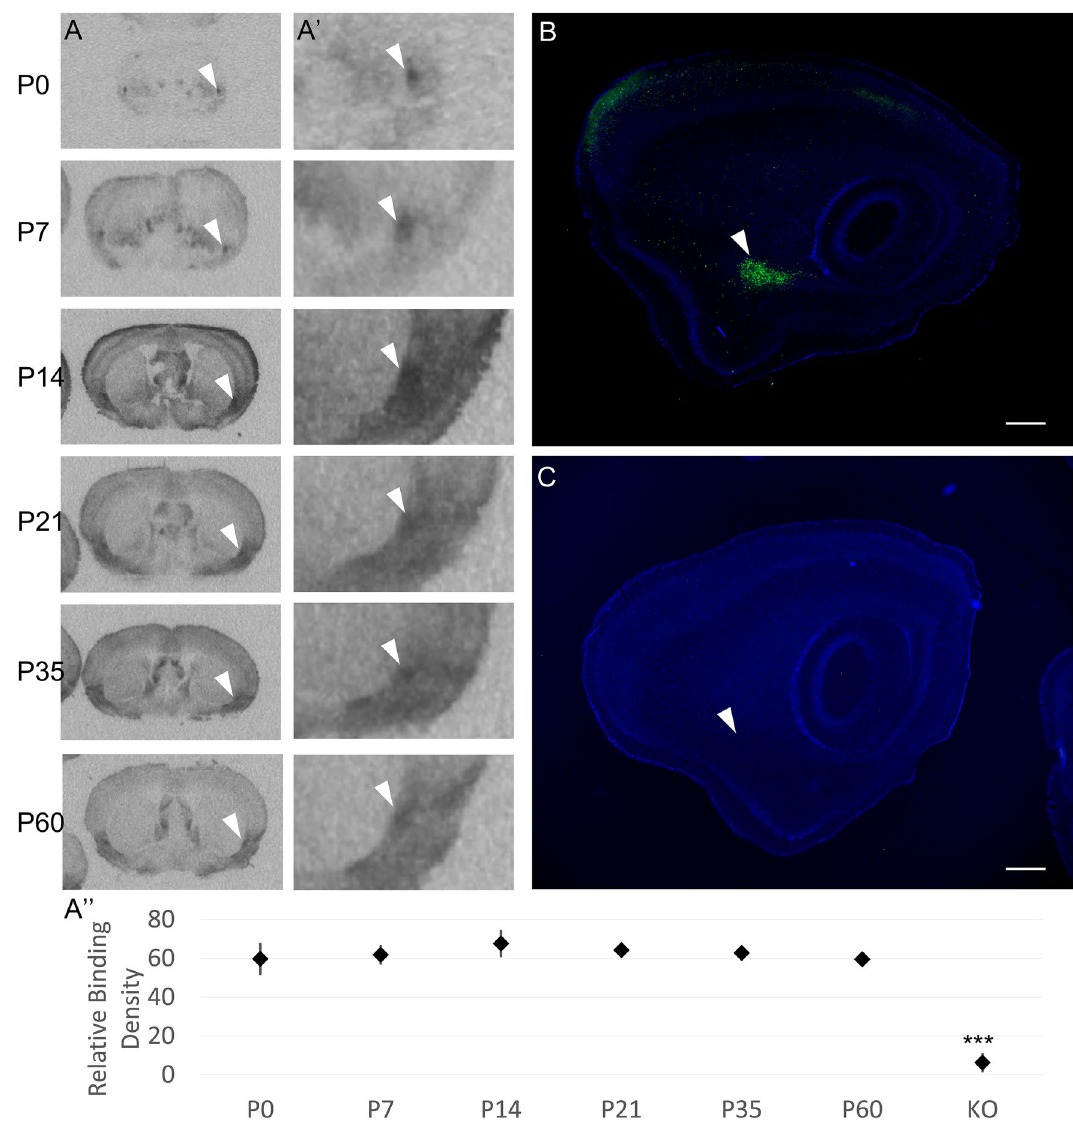
Figure 1. OXTR is produced by and present in the endopiriform nucleus (EPN) across development in mice. ( A ) Previously unpublished autoradiographic images selected from prior work by Hammock and Levitt (2013) demonstrate OXTR ligand binding in the EPN from birth in C57BL/6J mice. White arrowheads in A and A ′ (4 × zoom) point to the dorsal EPN in the coronal plane at post-natal day 0 (P0), P7, P14, P21, P35, and P60. OXTR ligand binding was present in both males and females at all ages examined. ( A ″ ) There were no significant differences across age or sex. All ages were significantly different from adult OXTR knock-out (n = 3 per age/sex, relative binding mean ± S.E.M., ***p < 0.001). ( B ) Sagittal view of Oxtr-EGFP reporter mouse at P21 (enhanced with immunofluorescence for EGFP, counterstained with DAPI) demonstrates the expression of the EGFP reporter throughout the rostro-caudal extent of the EPN. ( C ) There is no EGFP signal in a transgene negative sample. White arrowheads in B and C show the EPN at P21. Scale bar = 0.5